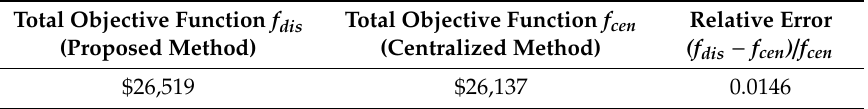
Table 3. Comparison Results.